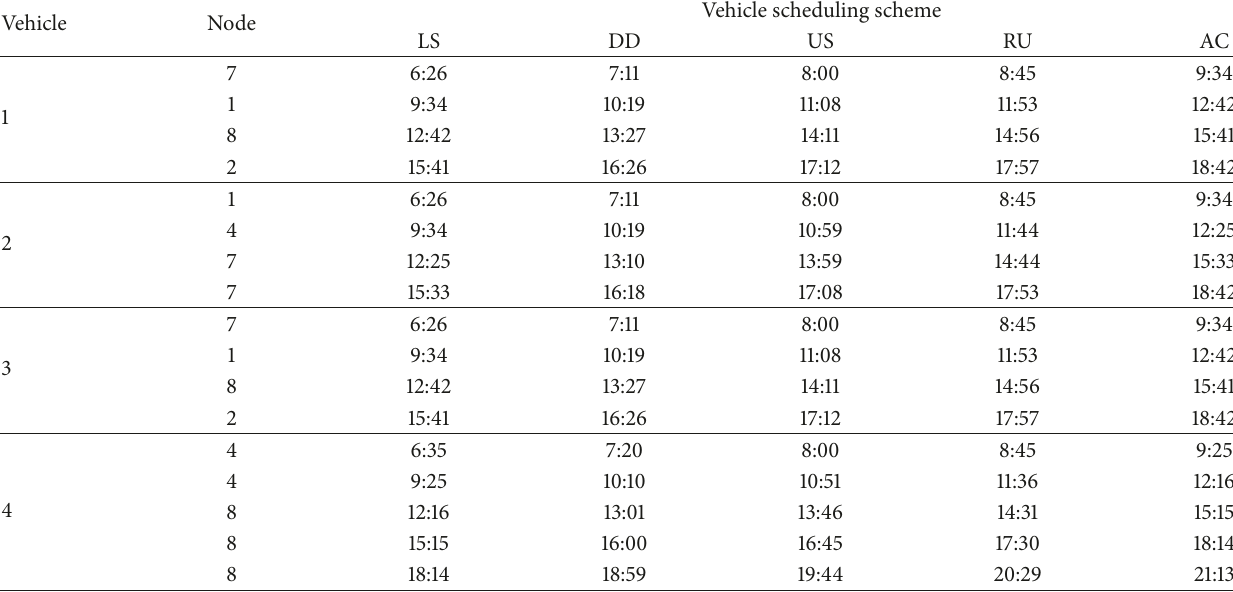
Table 5: Vehicle scheduling plan (for solution